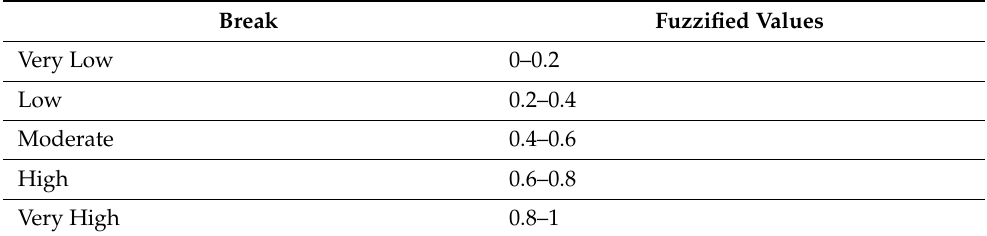
Table 2. Breaks assigned to fuzzy values for flood resilience indicator maps as well as the overall index